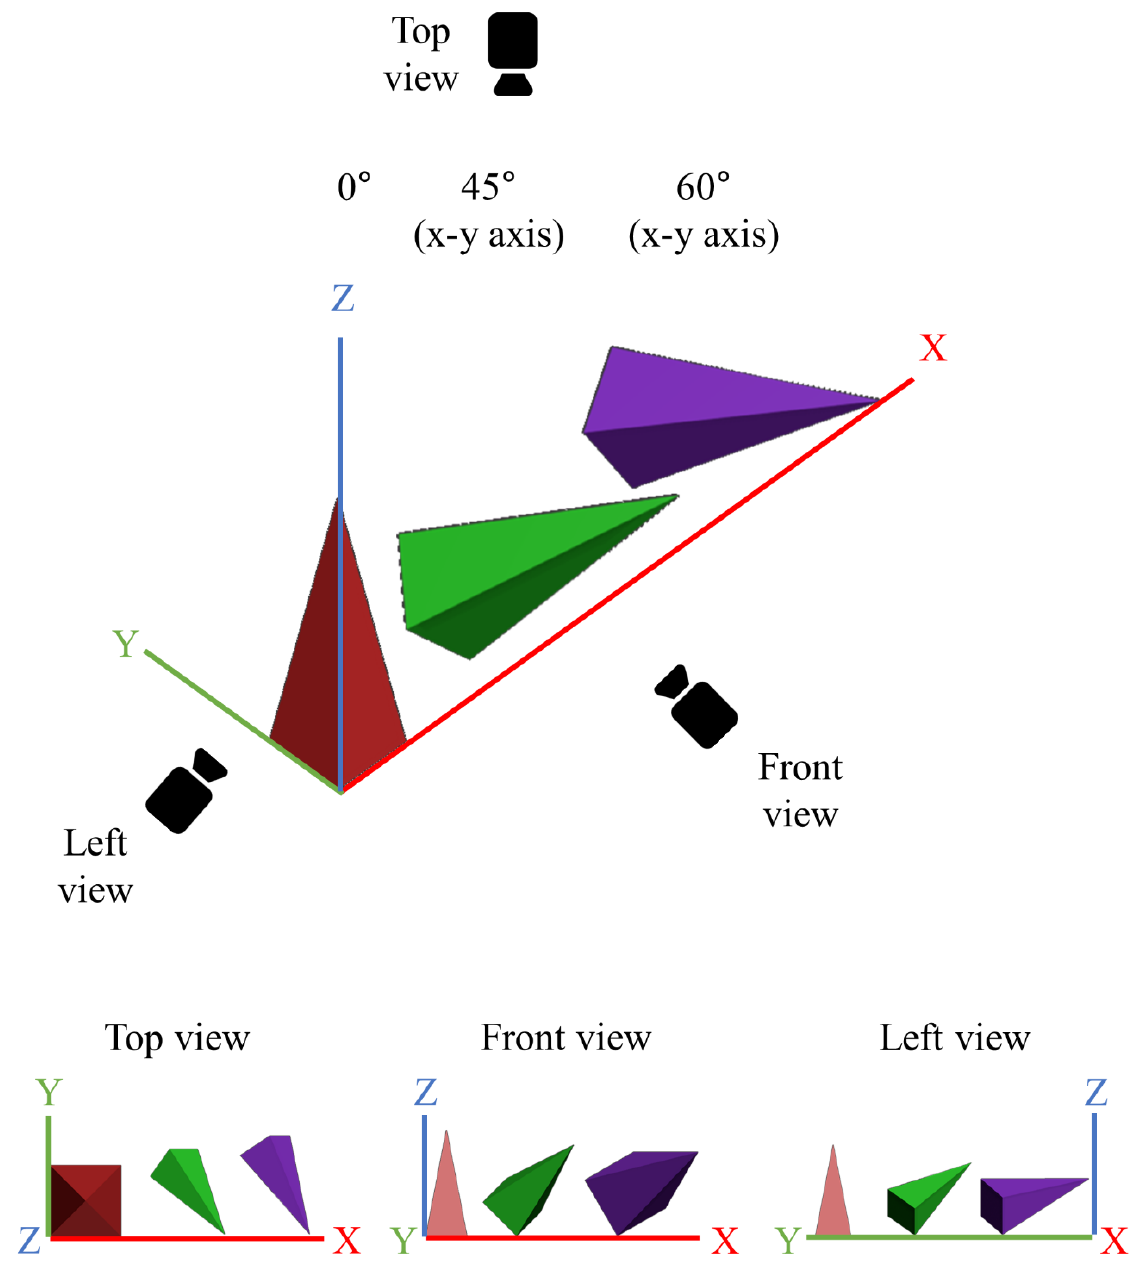
Figure 6. 3D designs of the microneedles, which were rotated the printing angles at 0°, 45°, and 60° to both x and y axes with top, front, and left view.